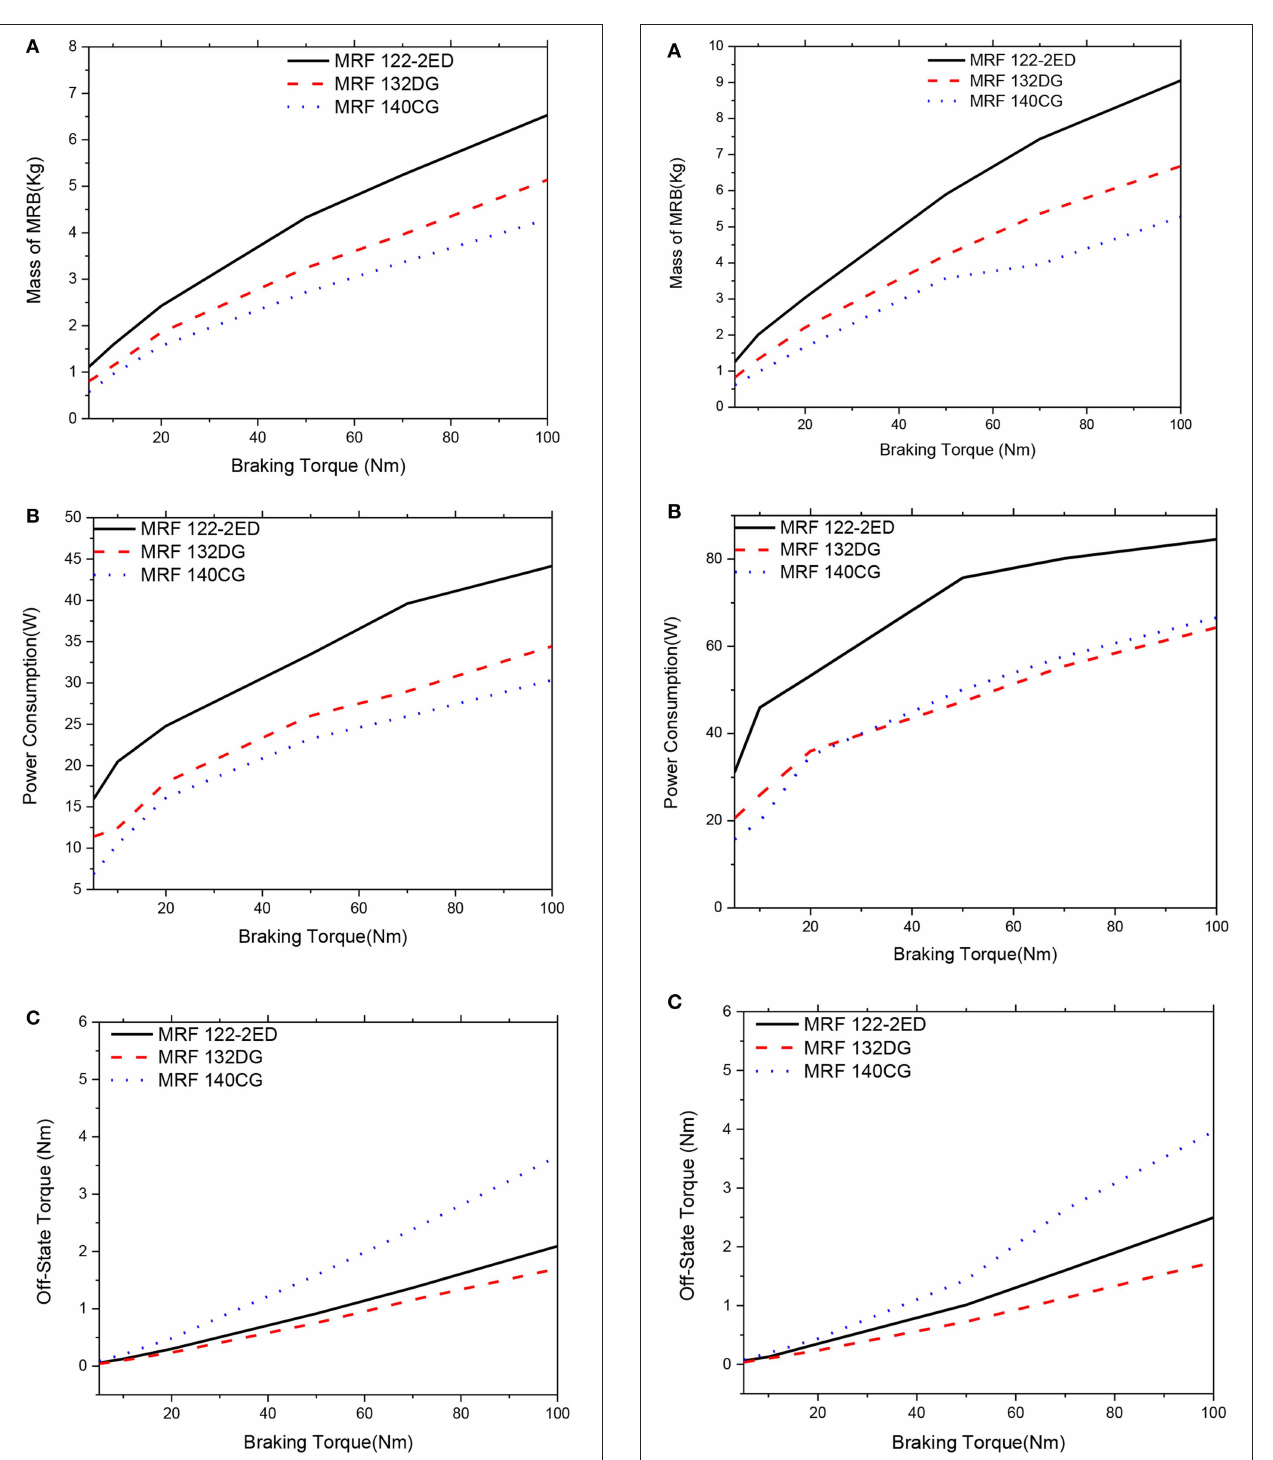
Frontiers in Materials |